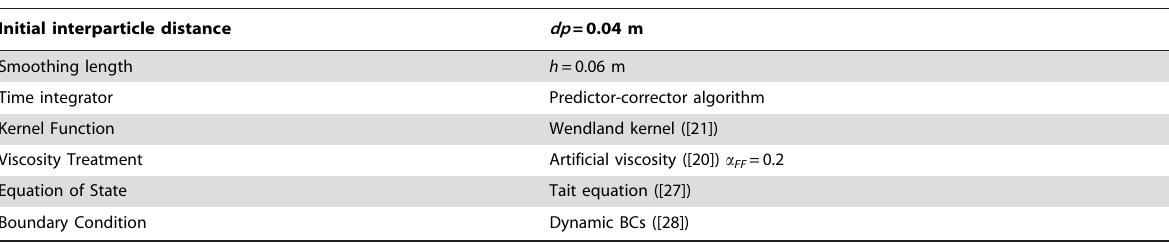
Table 1. SPH parameters in DualSPHysics.